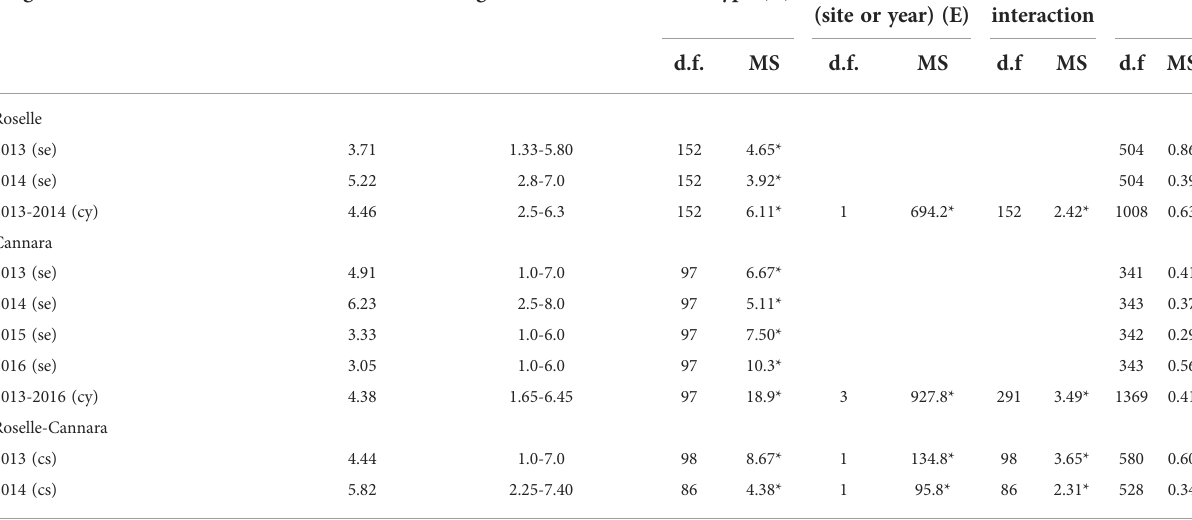
TABLE 1 Summary of ANOVA of male cone production of C. sempervirens clones. Single/combined environments Mean scores Range of mean scores Genotype